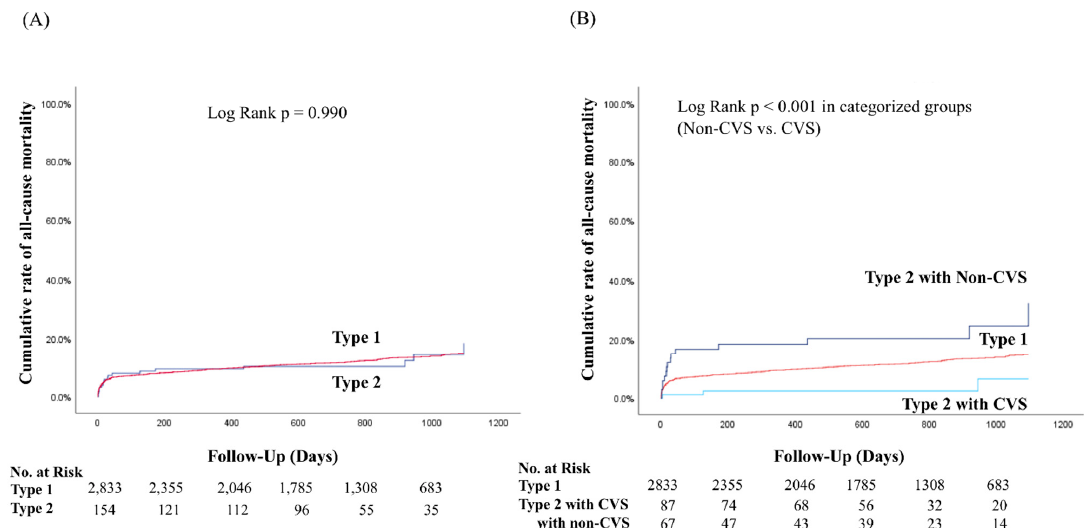
Figure 2. Kaplan–Meier estimates of all-cause mortality between Type 1 MI and Type 2 MI ( A ) and Table 2. MI is stratified into two groups ( B ) over a 3-year period. Table 3. Multiple regression analyses for predicting all-cause mortality in the Type 1 MI Group.